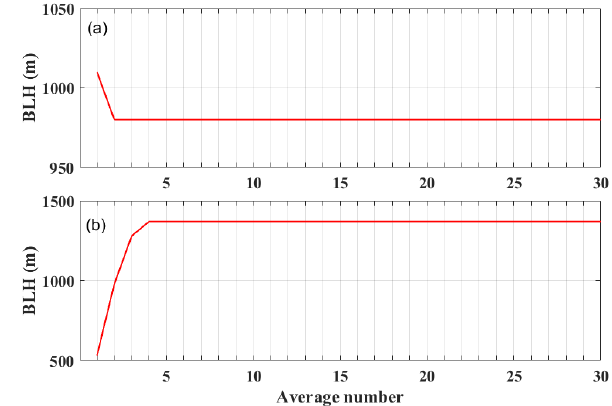
Figure 7. Relationship between the horizontal smoothing num- ber and BLH under different cases: (a) 4 October 2013 and (b) 12 February